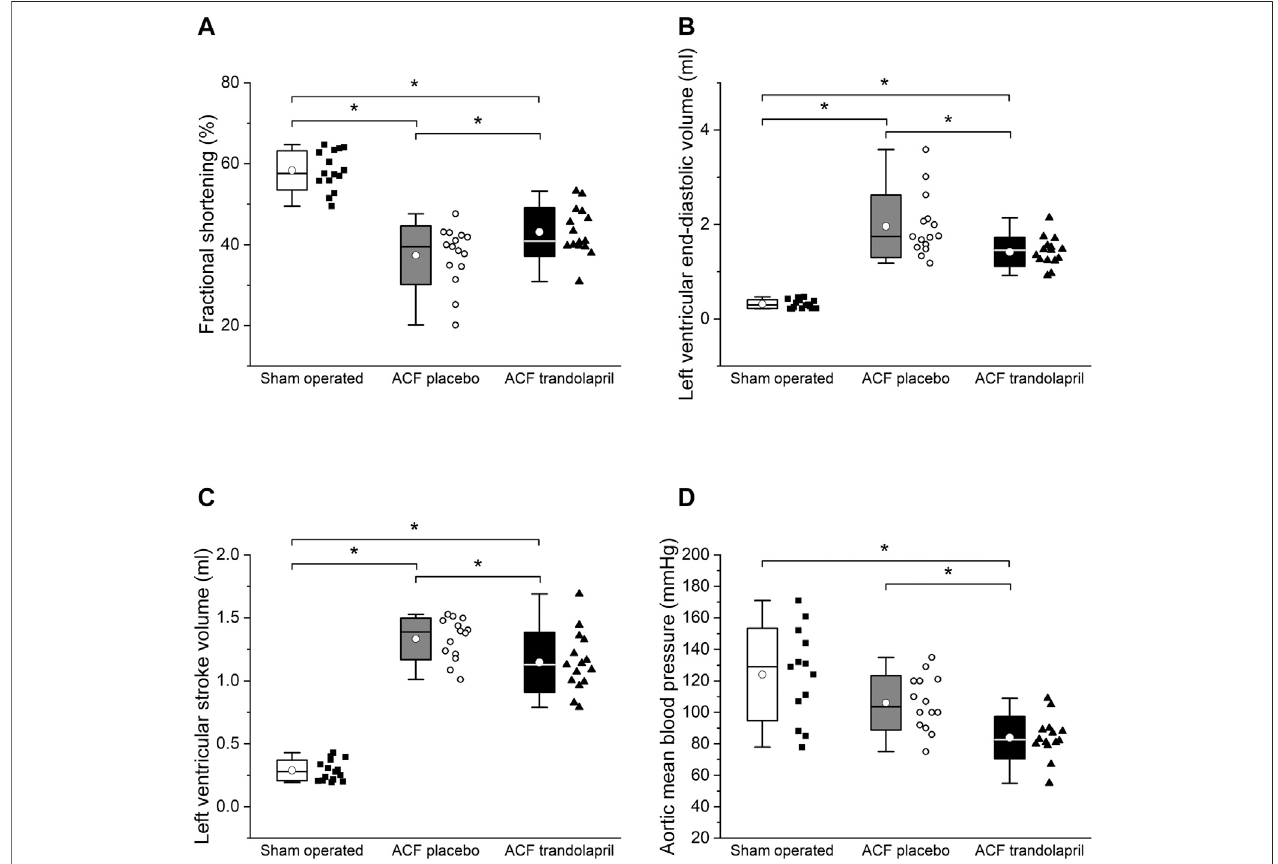
FIGURE 3 | Hemodynamics by echocardiography. (A) Left ventricular fractional shortening in sham-operated rats ( n (cid:1) 15), ACF rats ( n (cid:1) 15) and ACF rats with trandolapril ( n (cid:1) 15). (B) Left ventricular end-diastolic volume in sham-operated rats ( n (cid:1) 15), ACF rats ( n (cid:1) 15) and ACF rats with trandolapril ( n (cid:1) 15). (C) Left ventricular